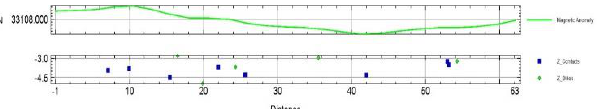
Figure 16: Total magnetic intensity profile for traverse 2 location1